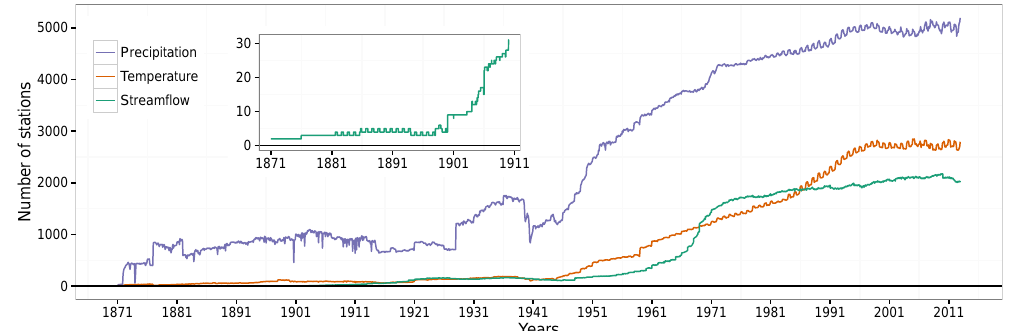
Figure 1. Evolution of the monthly averaged number of available precipitation and temperature stations in the Météo-France database (as of March 2015) since 1871 as well as the daily number of discharge stations in the Banque HYDRO French database since 1871.